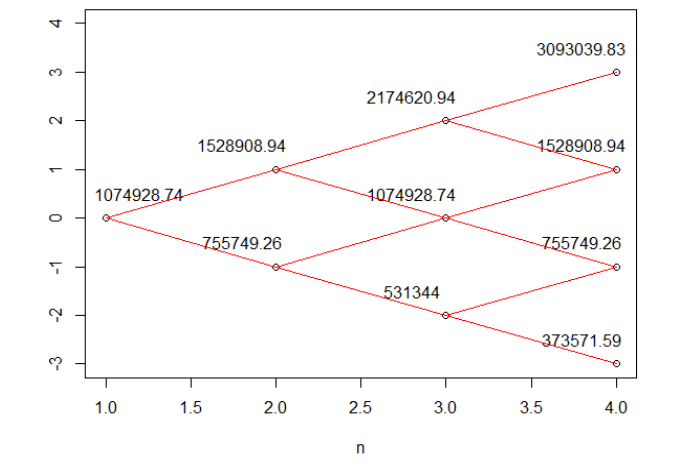
Figure 3. Tree 1 option to contract